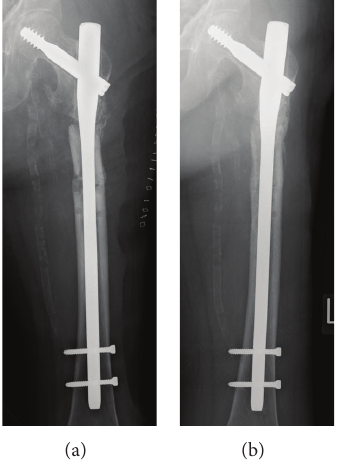
Figure 2: After surgery at our hospital. (a) Replacing the nail with the longer nail supplemented with autologous bone grafting at the long-standing nonunion site. (b) Bony union of both the older and newer